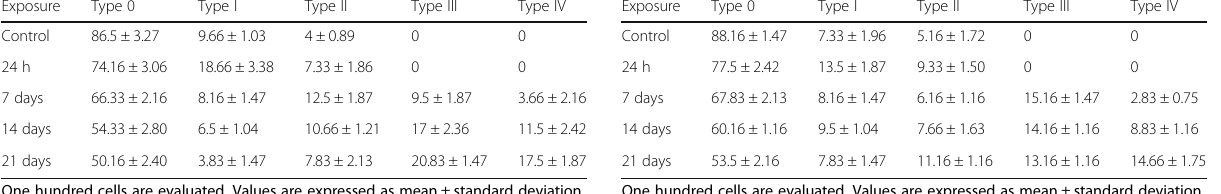
Table 1 Nucleoids in various damage degrees in the gill of C. carpio on exposure to karanjin Exposure